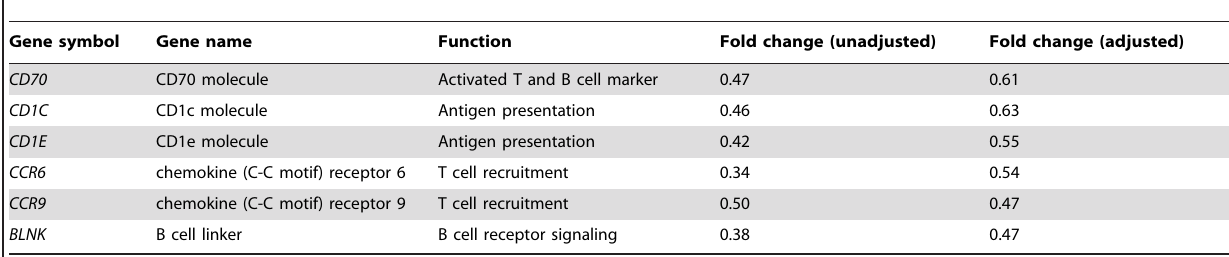
Table 5. Genes involved in adaptive immune response that were downregulated in third trimester pregnant women at the end of the controlled feeding